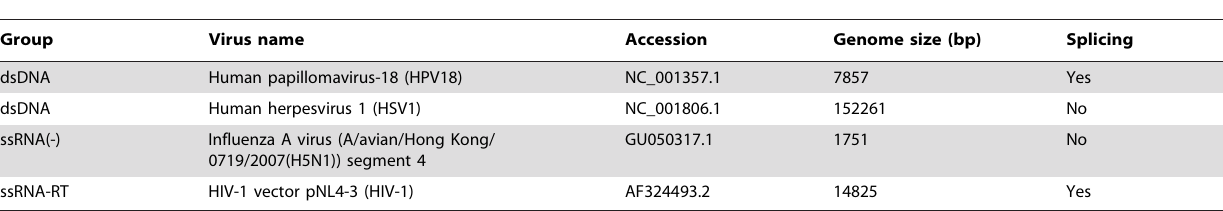
Table 1. Information about four different viruses used in this study.